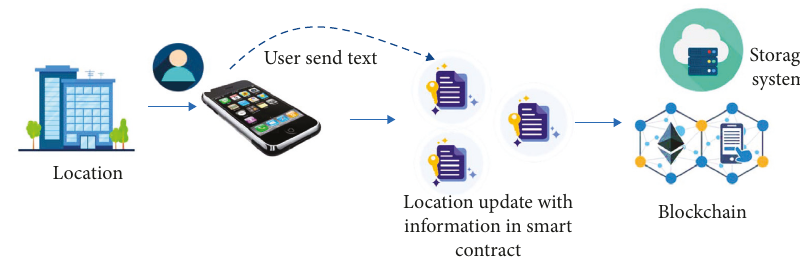
Figure 4: The user logs on to the site and records information in the blockchain